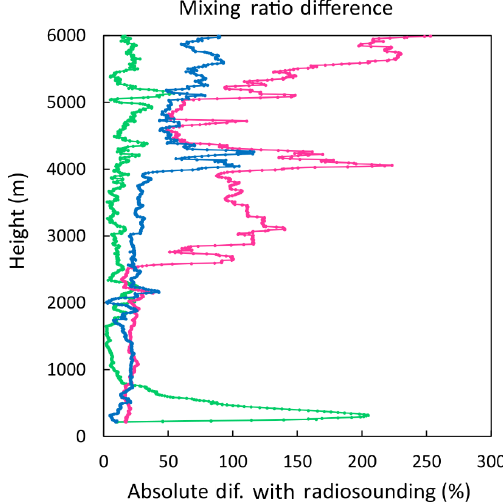
Figure 3. Absolute difference (%) between the mixing ratio of water vapor from radiosoundings and lidar (green), microwave radiome- ter (red) and WRF simulations (blue). All six high-resolution ra- diosounding cases from the HygrA-CD campaign are used (15, 17, 18, 20, 21 May and 1